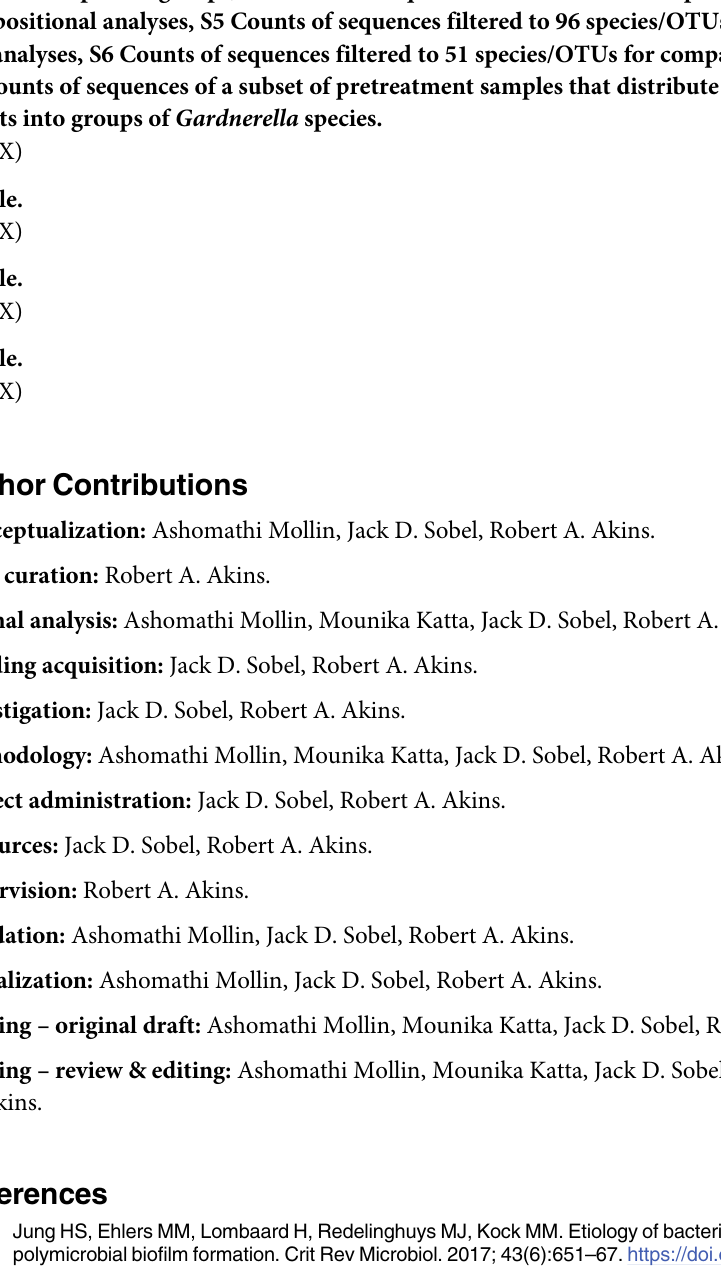
S2 Fig. Phylogenetic trees all representative OTUs. (PDF) S3 Fig. Relative pre- and post-treatment abundances. S4 Fig. Percent abundance of species pre- &